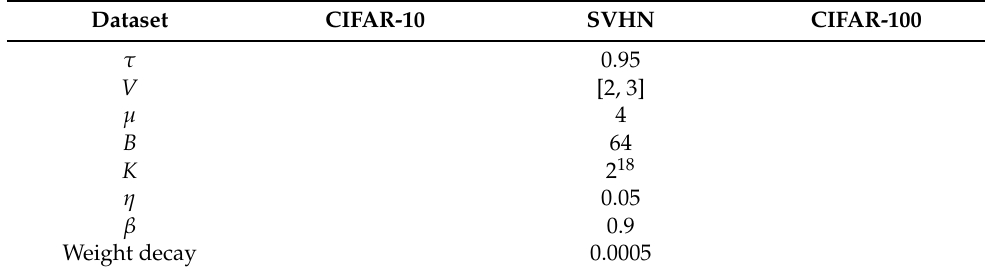
Table 1. List of hyperparameters for all